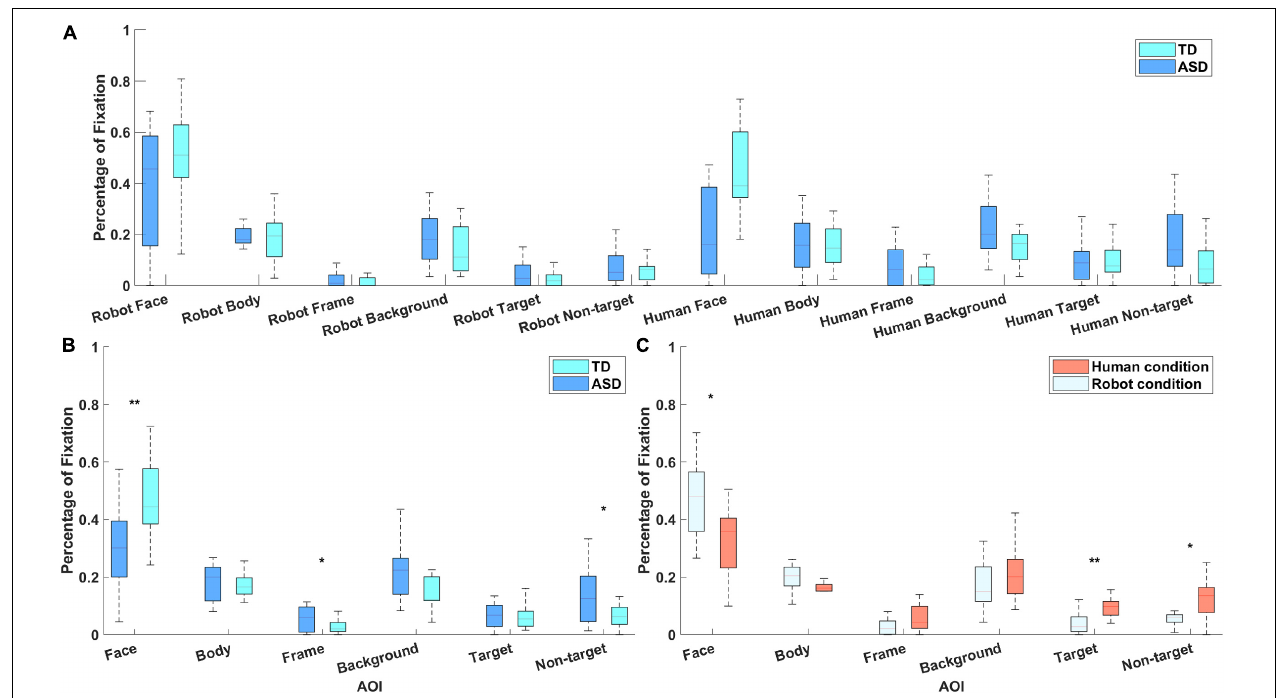
FIGURE 4 | (A) The percentage of fixation time spent on different areas of interest by participants with ASD and TD participants. (B) Results of post hoc analysis of the interaction between group and area of interest, indicating that the TD group fixated longer than the group with ASD on the agent’s face, whereas the ASD group looked for longer than the TD group at the picture frame and non-targets. (C) The interaction between stimulus type and area of interest, demonstrating that all participants spend more time looking at the face area in the robot condition ( p = 0.038), and more time looking at the target and non-targets in the human condition. ∗∗ Means that the significant level is p < 0.01 and ∗ means p <